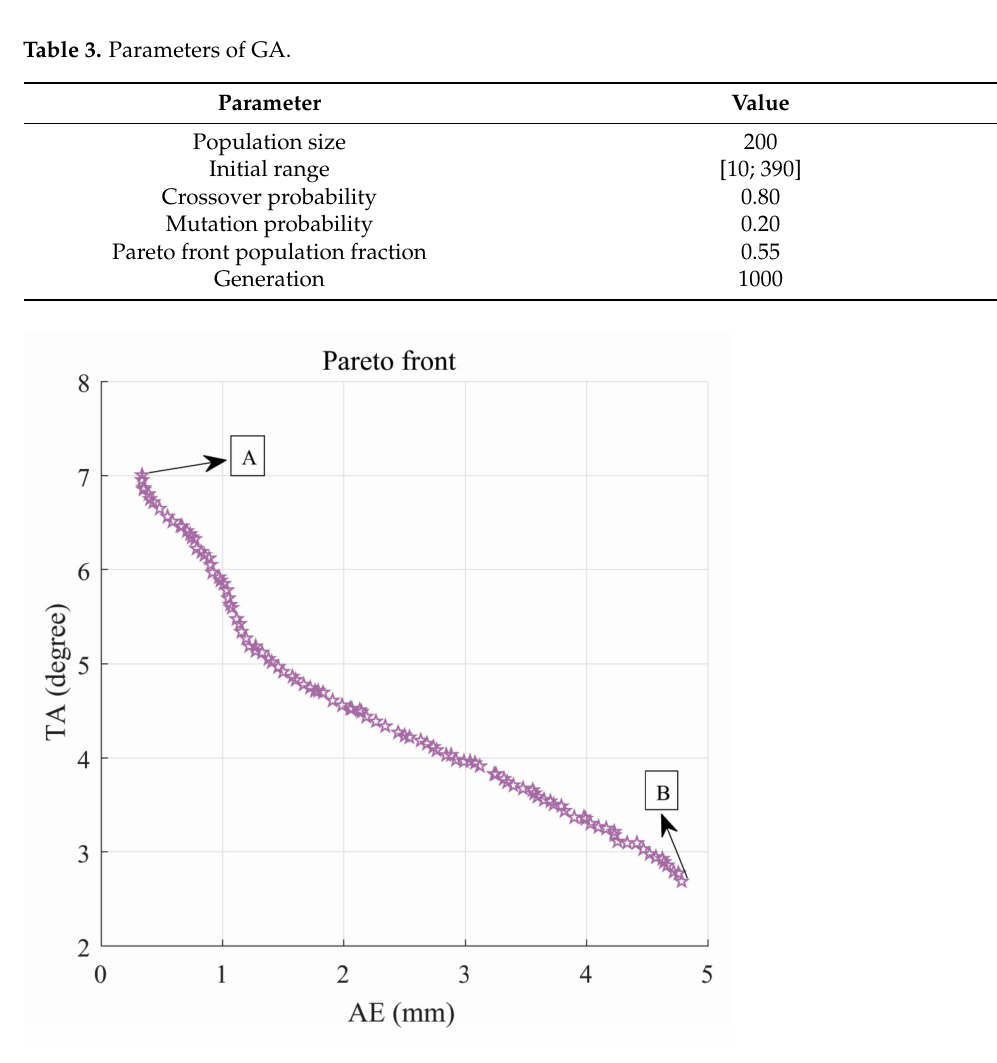
Figure 7. The best fitness function over the entire run of GA-based optimization